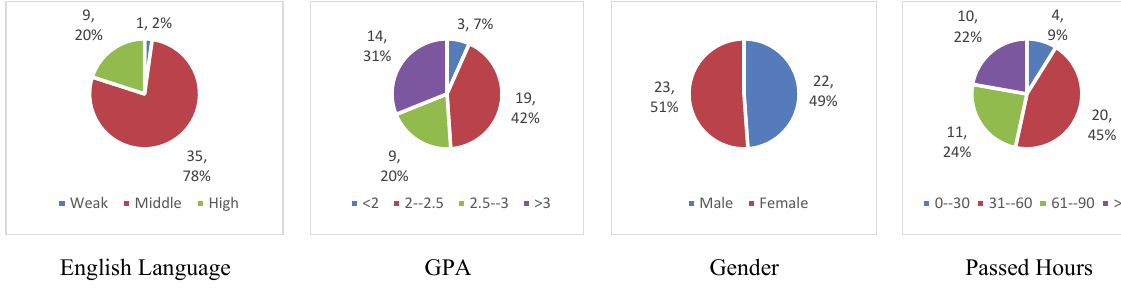
Fig. 1. Demographic information of the participants